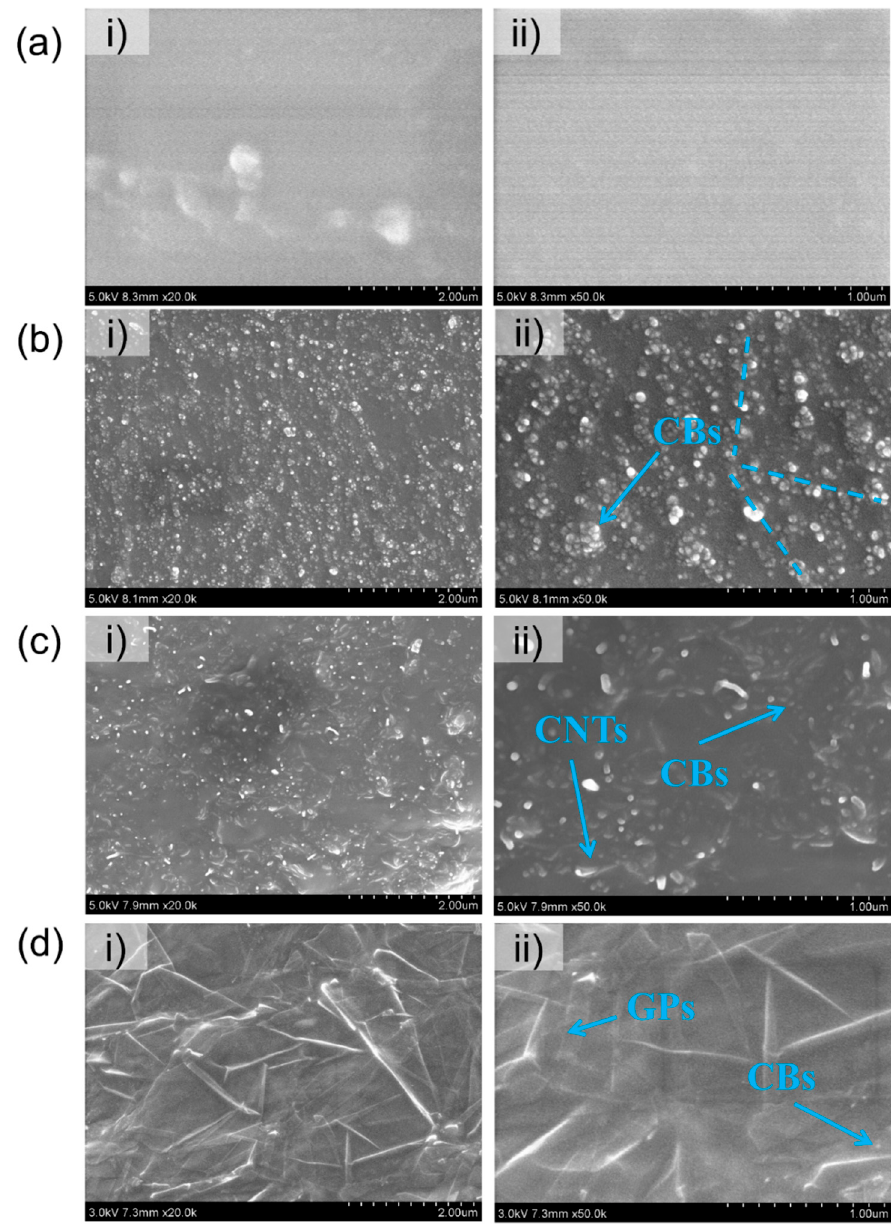
Figure 2. ( a ) SEM micrographs of RTV films of 20,000 × ( i ) and 50,000 × ( ii ) magnification, ( b ) SEM micrographs of CB-embedded composites films at 20,000 × ( i ) and 50,000 × ( ii ) magni- fication, ( c ) SEM micrographs of the CB/CNT-embedded composites films at 20,000 × ( i ) and 50,000 × ( ii ) magnification, ( d ) SEM micrographs of the CB/GP-embedded composites films at 20,000 × ( i ) and 50,000 × ( ii )